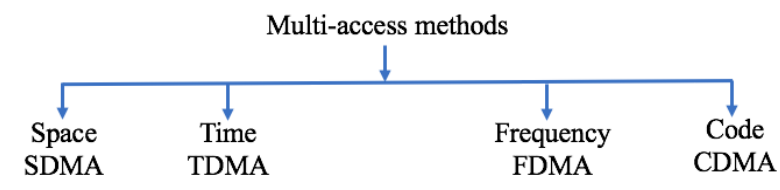
Figure 3. Multi-access methods.